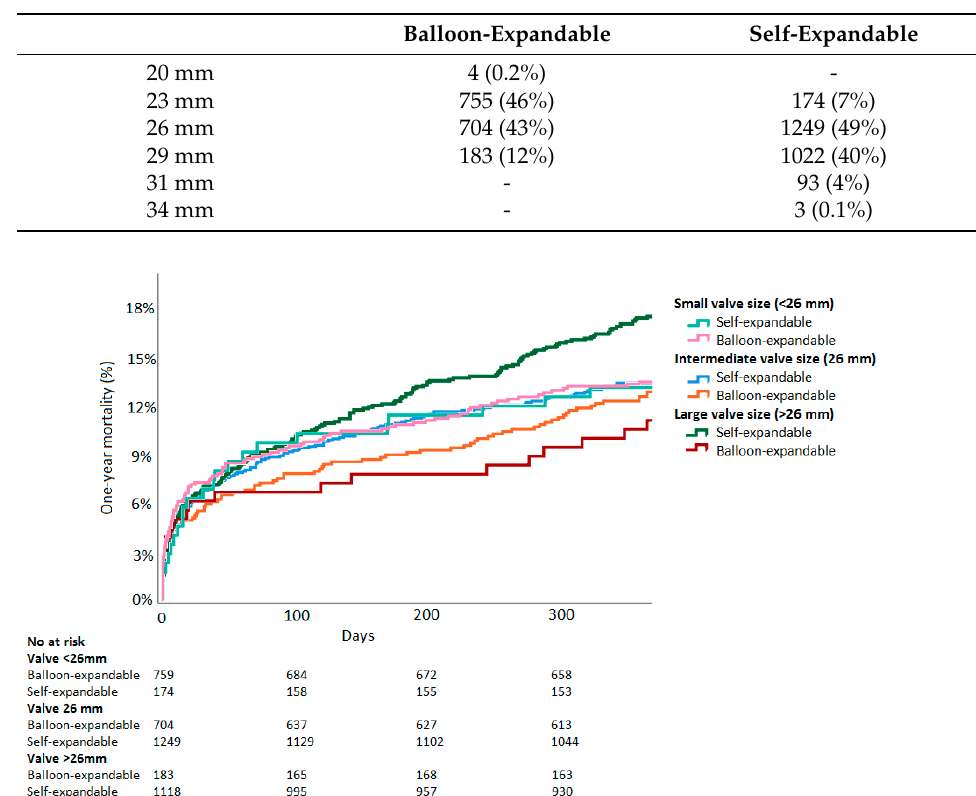
Figure 2. Time-to-event Kaplan–Meier all-cause mortality curve of balloon-expandable vs. self-expandable valves in patients undergoing transcatheter aortic valve implantation. Table 2. Distribution of valve sizes in balloon-expandable and self-expandable valves.